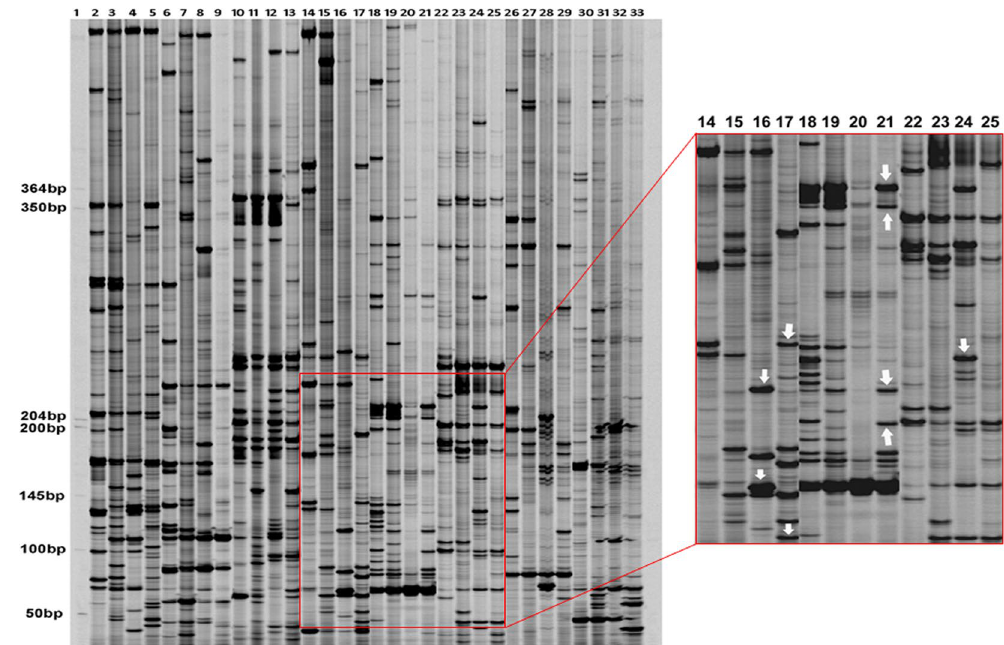
Figure 2. Representative cDNA-AFLP profiles of non-inoculated and Fusarium udum inoculated ICP 2376 and ICP 8863 samples using different primer combinations. Lanes 2, 6, 10, 14, 18, 22, 26, 30: non-inoculated control ICP 2376; lanes 3, 7, 11, 15, 19, 23, 27, 31: non-inoculated control ICP 8863; lanes 4, 8, 12, 16, 20, 24, 28, 32: inoculated ICP 2376; lanes 5, 9, 13, 17, 21, 25, 29, 33: inoculated ICP 8863; The primer combinations used were; lanes 2–5: E-AT/M-GA; lanes 6–9: E-AT/M-GT; lanes 10–13: E-AT/M-TG; lane 14–17: E-AT/M-TC; lane 18–21: E-AT/M-CA; lanes 22–25: E-AT/M-CG; lanes 26–29: E-AT/M-CAT; lanes 30–33: E-AT/M-CTA. Lane 1: